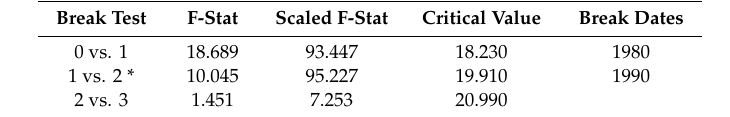
Table 4. Structural break test